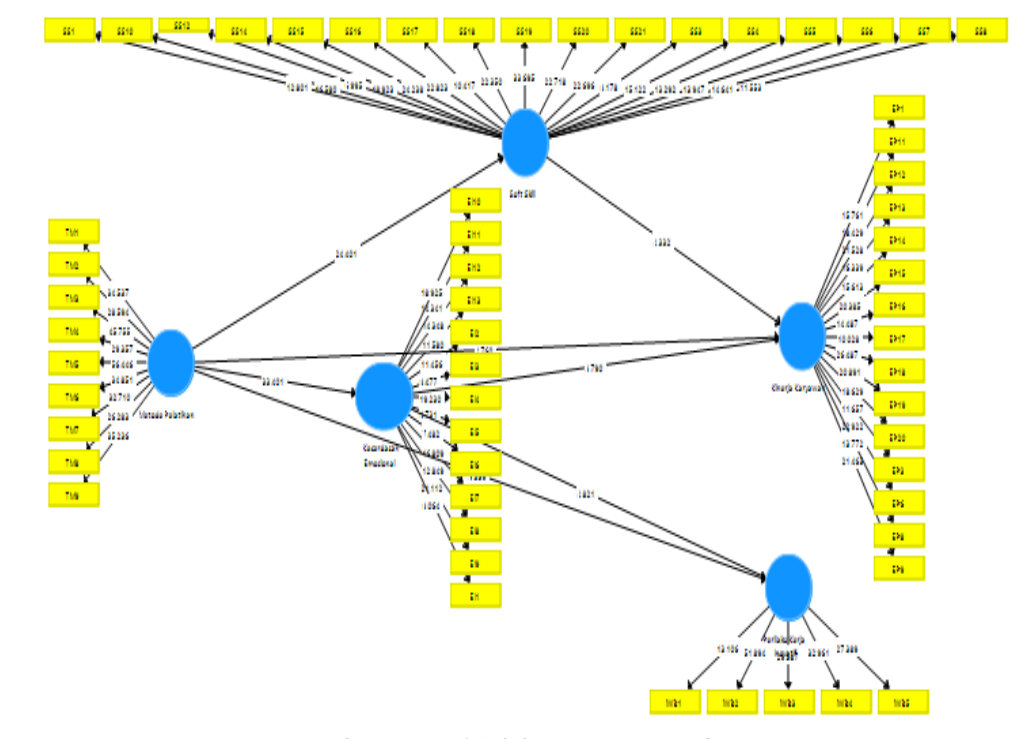
Figure 3. Display of PLS-SEM Boostraping Output